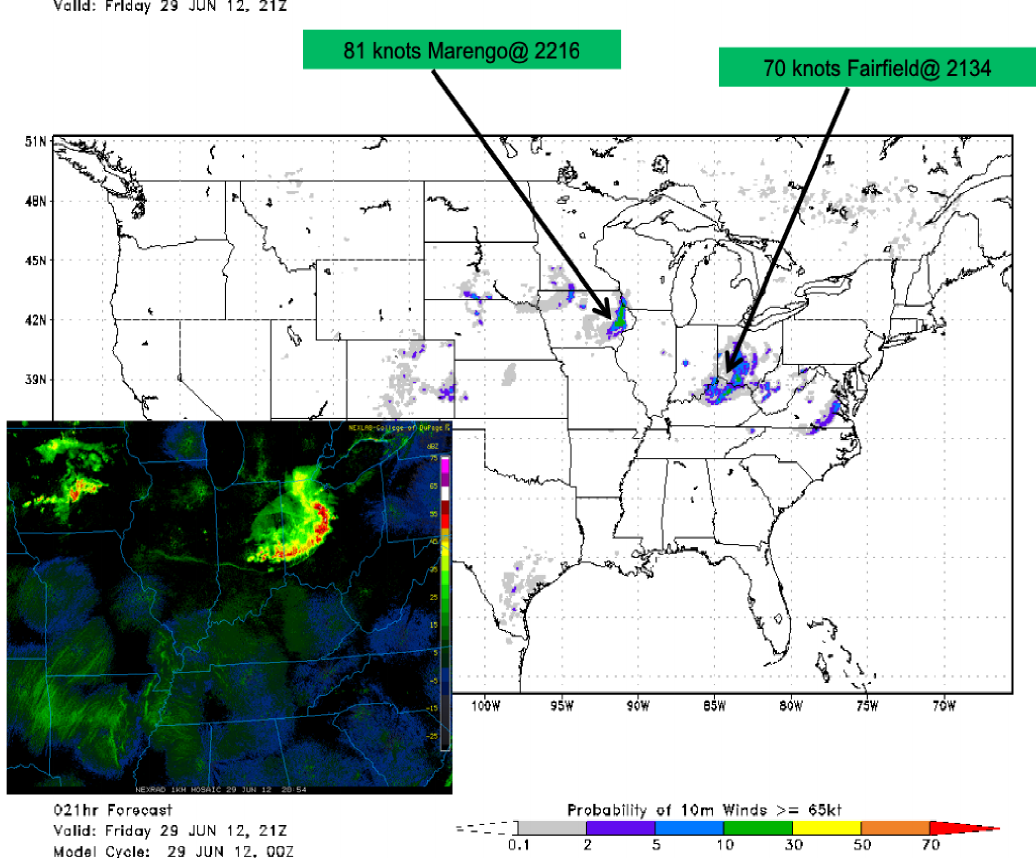
Figure 11. Probability (percent) of wind gusts exceeding 65 knots (33.4 m/s) from the operational 4-km MEPS run initialized at 0000 UTC on 29 June 2012 valid at 2100 UTC the same day. Two observed wind report time/locations noted on the image. Inset radar courtesy of the College of DuPage website valid 2054 UTC.